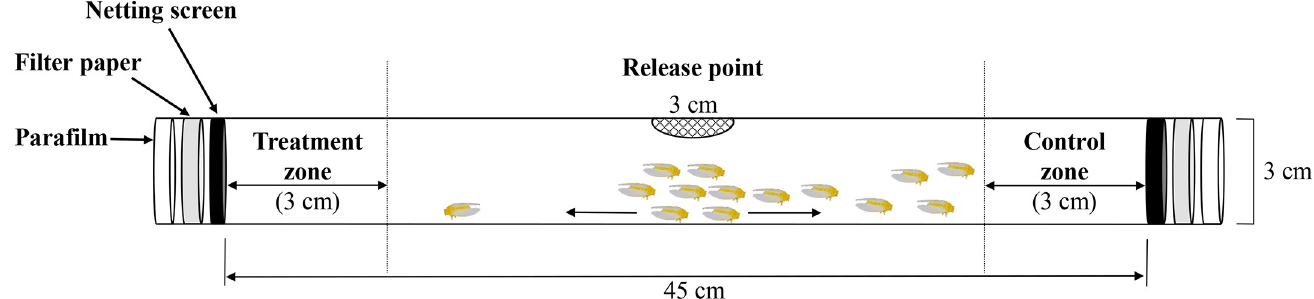
Fig 2. The apparatus used in bioassays. Before the assay, methyl benzoate (treatment) solution was applied to the filter paper and placed between the netting screen and the bottom of the assembly, and then the tube was covered with parafilm. The opposite end of the tube was used as the control.